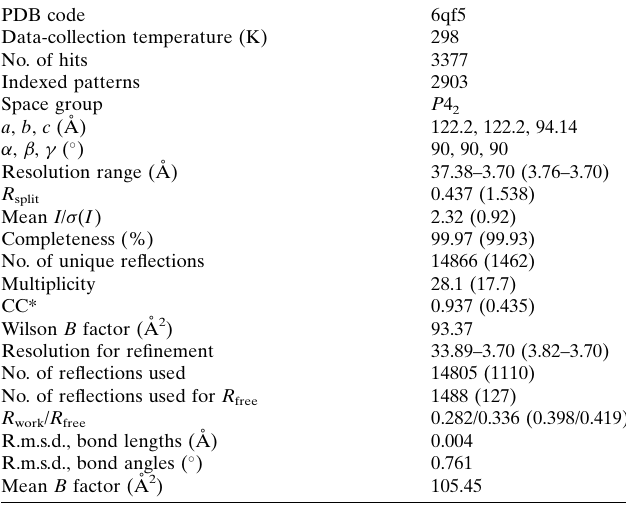
Table 3 Data-collection and refinement statistics for human aquaporin 2 crystal- lized on Roadrunner II